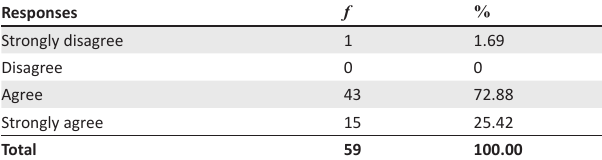
TABLE 2: Respondents’ views on whether community nurses should be able to identify tuberculosis symptoms and isolate infectious patients ( n = 59). Responses f